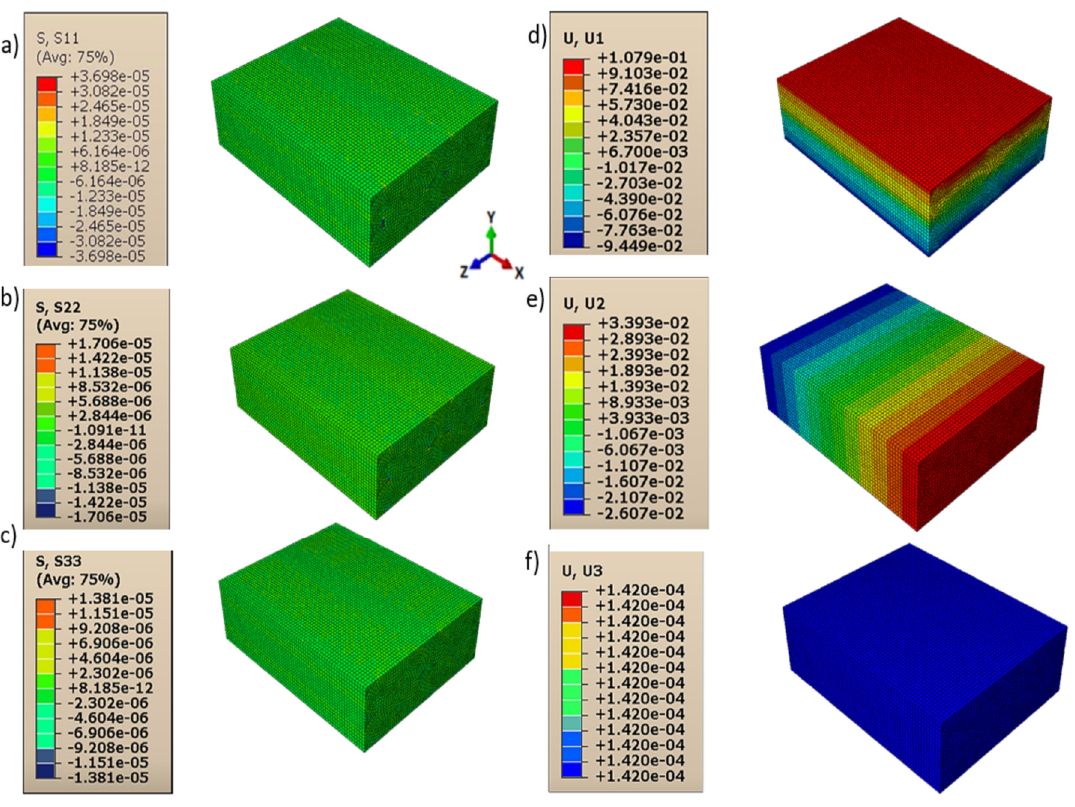
Figure 13. Load cases to evaluate G 12 : ( a ) stress in direction 11; ( b ) stress in direction 22; ( c ) stress in direction 33; ( d ) displacement in direction 11; ( e ) displacement in direction 22; ( f ) displacement in direction 33.